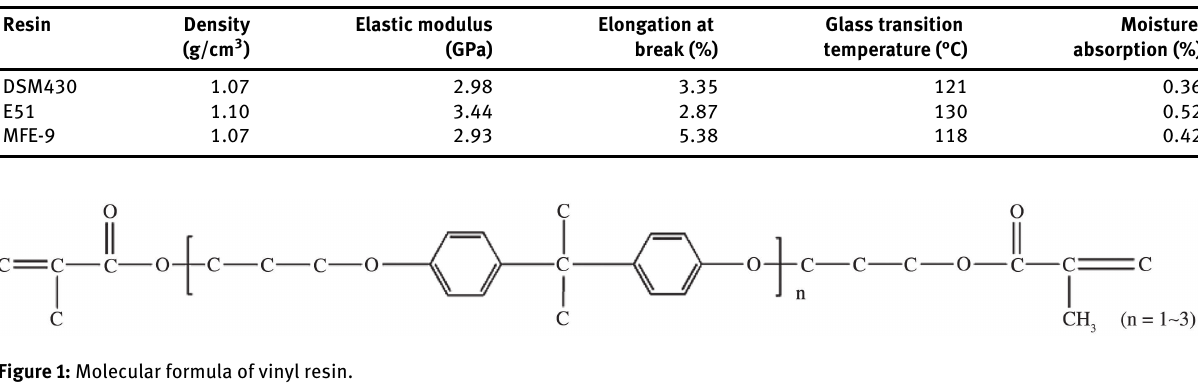
Figure 1: Molecular formula of vinyl resin.